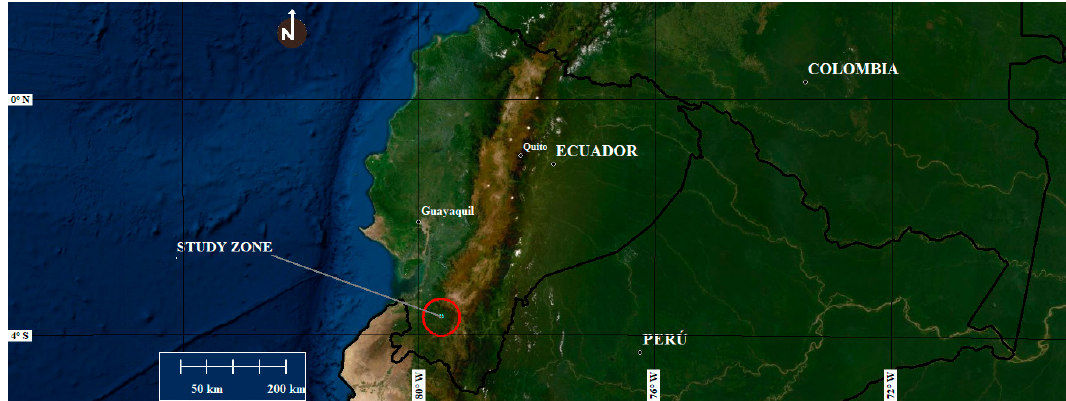
Figure 1. Location of the study area in the South of the country, in the Andes Mountains.